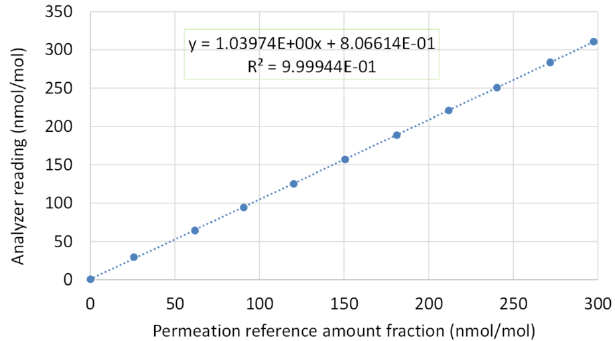
Figure 7. A typical calibration line obtained for an NH 3 analyzer (dotted line). Large blue dots indicate the analyzer response for each generated NH 3 reference (in both cases, the average of the last 30min of the reading and generation). The error bars corresponding to the standard deviation of the analyzer reading ( y axis) and of the generated references ( x axis) are hidden by the large blue